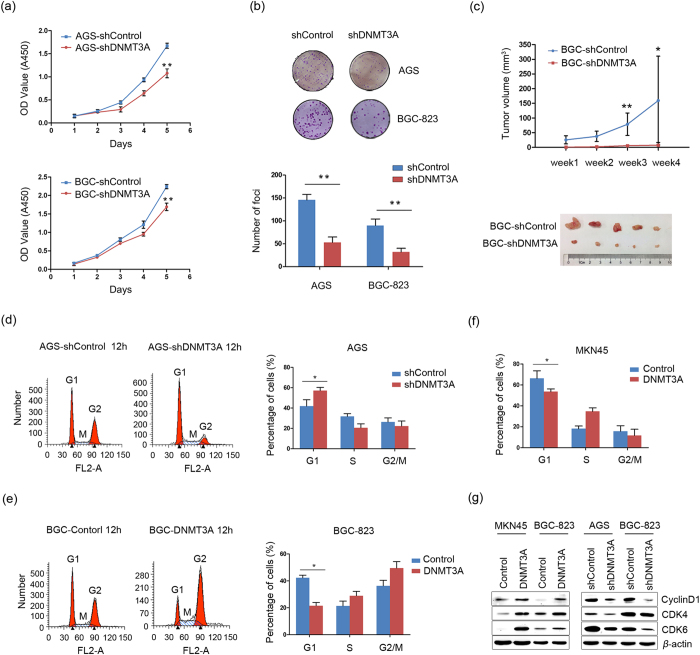
DNMT3A has tumor-promoting effects in vitro and in vivo.(a) The growth rates of AGS-shDNMT3A and BGC-shDNMT3A cells were detected with CCK-8 proliferation assay and are shown as the mean ± SD of three independent experiments (**P < 0.01). (b) Representative images of foci formation in AGS-shDNMT3A and BGC-shDNMT3A cells (upper panels). Colonies were counted, and the results are depicted in a bar chart (bottom panels). The values indicate the mean ± SD of three independent experiments (**P < 0.01). (c) BGC-shControl or BGC-shDNMT3A cells were injected into the right dorsal flanks of nude mice (n = 5 per group), respectively. The tumor growth curve shows that DNMT3A knockdown significantly inhibited tumor growth in the mice (upper panels; *P < 0.05, **P < 0.01). Images of tumors formed in the nude mice injected with the indicated cells are also shown (bottom panels). (d) Flow cytometry analysis of the distribution of cell cycle phases in AGS-shControl and AGS-shDNMT3A cells (left panels). The percentages of cells in the G1, S, and G2/M phases are shown in the bar chart as the mean ± SD of three independent experiments (right panels; *P < 0.05). (e) Flow cytometry analysis of the distribution of cell cycle phases in BGC-Control and BGC-DNMT3A cells (left panels). The percentages of cells in the G1, S, and G2/M phases are shown in the bar chart as the mean ± SD of three independent experiments (right panels; *P < 0.05). (f) The percentages of MKN45-Control and MKN45-DNMT3A cells in the G1, S, and G2/M phases are shown in the bar chart as the mean ± SD of three independent experiments (*P < 0.05). (g) Expression levels of cyclinD1, CDK4 and CDK6 were detected in DNMT3A overexpression MKN45 and BGC-823 cells (left panels) or in DNMT3A knockdown AGS and BGC-823 cells by western blot assay (right panels). β-actin was used as a loading control.